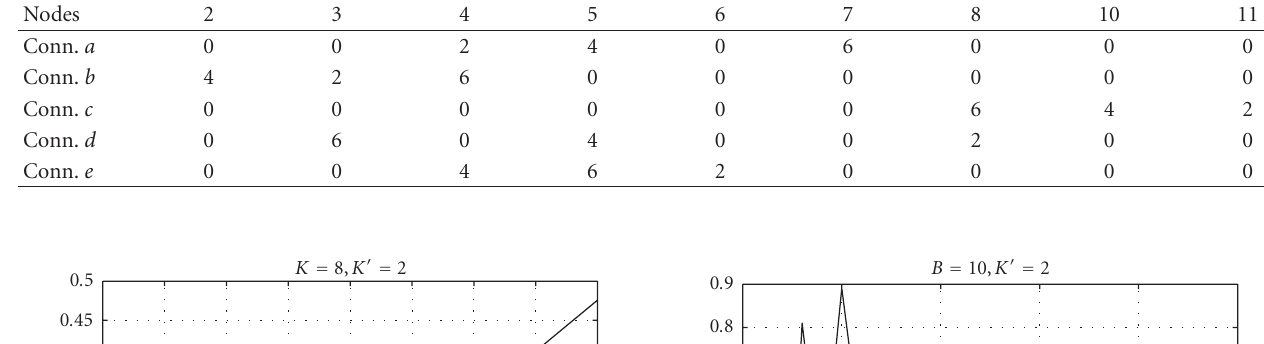
Table 2: Values of the dynamic maximum number of transmissions for K (cid:5) = 2 and K = 4. Nodes